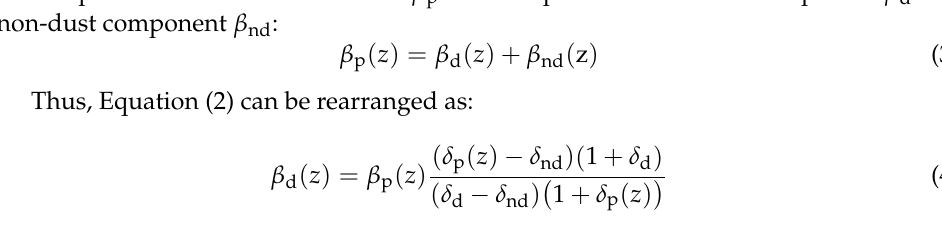
Figure 3. Monthly-averaged dust occurrence frequency ( a ), and the averaging top and base heights of the dust layers ( b ) over the Jianghan Plain from June 2006 to March 2021 obtained from nighttime CALIOP level-2 Vertical Feature Mask data. The solid lines in ( b ) denote the monthly averaged